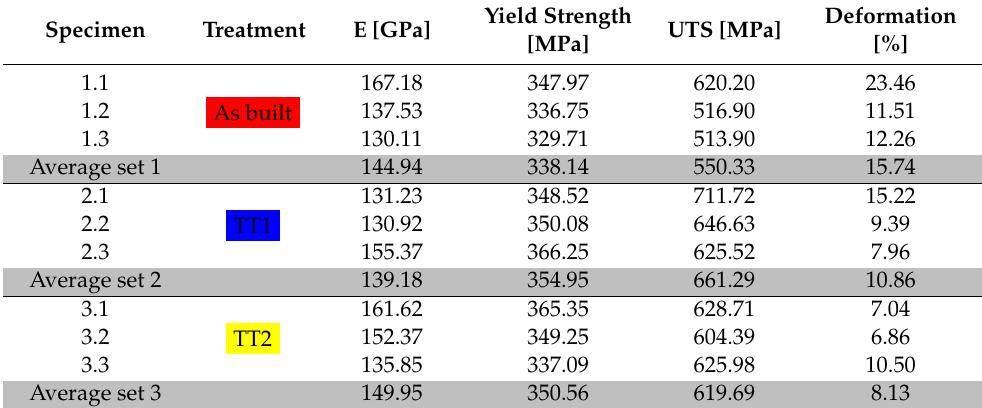
Table 6. Mechanical and physical properties of the specimens produced in argon atmosphere condition.